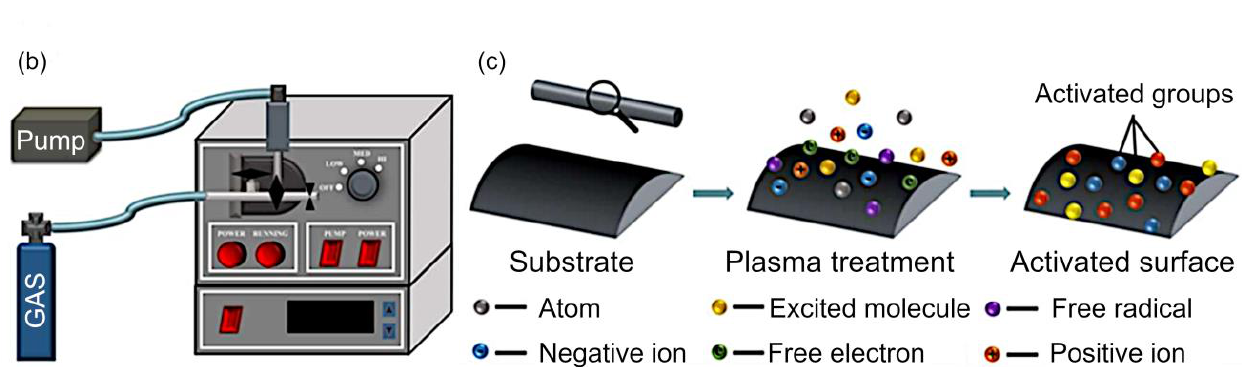
Figure 1. ( a ) When the surface of the substrate is exposed to plasma, multiple reactions between reactive molecules and radicals can lead to the formation of a film. In plasma, the ions and radicals are formed and accelerate toward the surface. Once they arrive at the surface of the substrate, the following reactions may take place: (1) adsorption and (2) desorption of reactive molecules; abstraction of H by (3) H radical and (4) other radicals; (5) reactive molecule abstraction by radical; direct chemisorption of (6) reactive molecules, and (7) H onto dangling bond; (8) transfer of adsorbed molecules on hydride sites; (9) chemisorption of adsorbed molecules into dangling bonds; and (10) sputtering of mono-hydride sites by ions. Reproduced Marvi et al. (2017) [29] under conditions of the BY-NC license. Diagram of the plasma treatment equipment: ( b ) plasma device; ( c ) mechanism of plasma interaction with the polymer surface. Reproduced from Lu et al. (2019) [30] under conditions of the CC BY license.